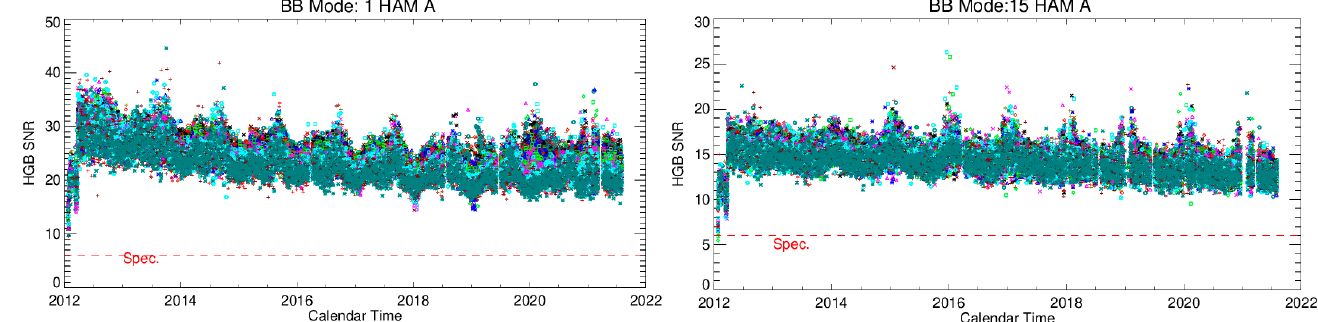
Figure 8. DNB SNR trend for HGS-B in two aggregation modes (mode-1 and mode-15). Different colors are used to plot the DNB 16 detectors.